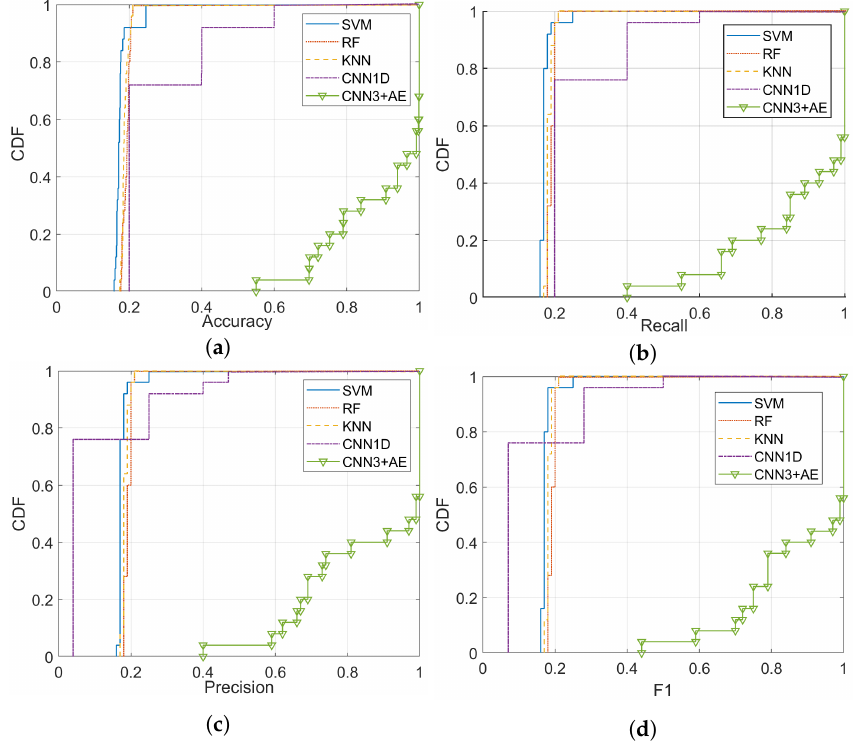
Figure 8. The overall performance cumulative distribution function (CDF) across a range of channel scenarios and signal-to-noise ratio (SNR) values: ( a ) Accuracy, ( b ) Recall, ( c ) Precision, and ( d ) F1.